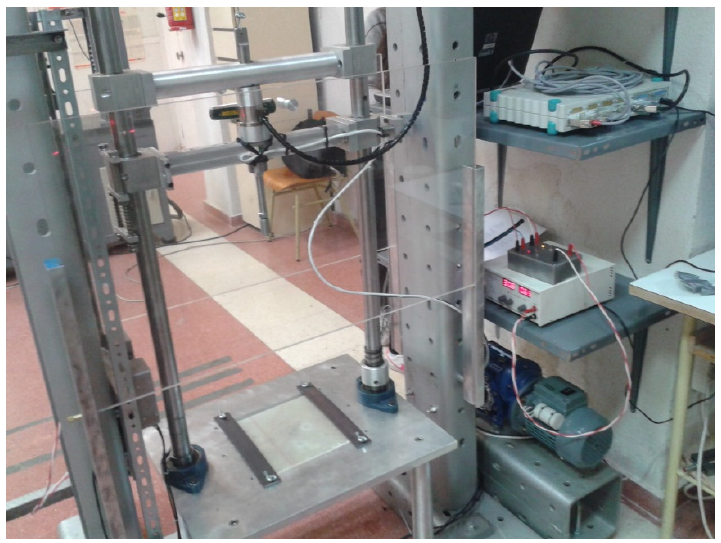
Figure 1. Test specimen manufacturing process: ( a ) Prepreg panel after curing process in vacuum pressure oven, ( b ) example of specimens drawn from prepreg for different cure times.